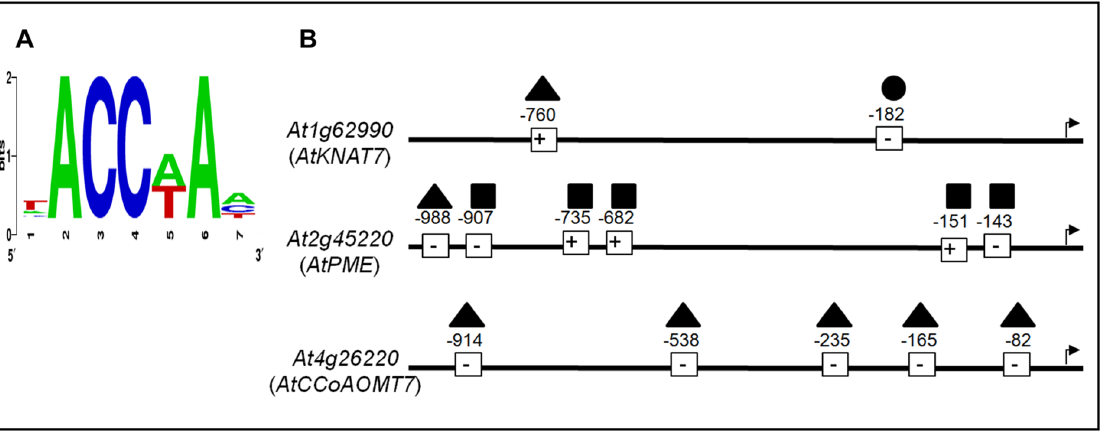
Figure 5. Sequences recovered from the CASTing assay were over-represented in all three promoter regions of predicted direct downstream targets of AtMYB61. (A) Sequence logo of the over-represented motifs in the promoter sequences of the three target genes of At MYB61, as determined by the Promomer algorithm [54] (average=2.9; Z -score=13; significance=0.001). Right: Schematic representation of the promoter regions of the three putative At MYB61 downstream target genes. (B) The three putative AtMYB61 direct downstream target genes,, KNOTTED1-like transcription factor (KNAT7, At1g62990); Caffeoyl-CoA 3-O-methyltransferase (CCoAOMT7, At4g26220), and pectin-methylesterase (PME, At2g45220), were identified by Romano et al (33). 1000 bp upstream regulatory regions were examined of the three genes. + / 2 indicate the orientation of CASTing target sequences relative to the sense coding strand; whereas, numbers indicate the position of these motifs relative to the putative transcriptional start (indicated by an arrow). Triangle represents ACCAAA, square represents ACCAAT, and circle represents